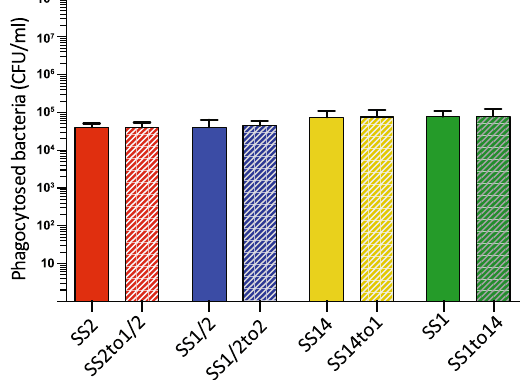
Figure 7. The antiphagocytic properties afforded to S. suis by CPS types 2, 1/2, 14, and 1 appear similar under in vitro conditions. Parental strains and isogenic mutants (1 × 10 7 CFU/ml) were incubated for 60 min with J774 macrophages (multiplicity of infection = 100) in the presence of 50% murine serum. Results represent the mean (CFU/ml) + SEM of four independent experiments. Statistical analyses using the Student’s t-test showed no significant differences in the number of internalized bacteria between